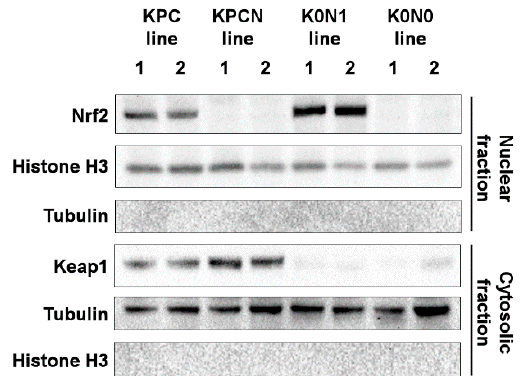
Figure 1. Expression of Nrf2 and Keap1 in KPC, KPCN, K0N1, and K0N0 lines. Histone H3 and tubulin were used as loading controls for the proteins present in nuclear and cytosolic fractions, respectively.